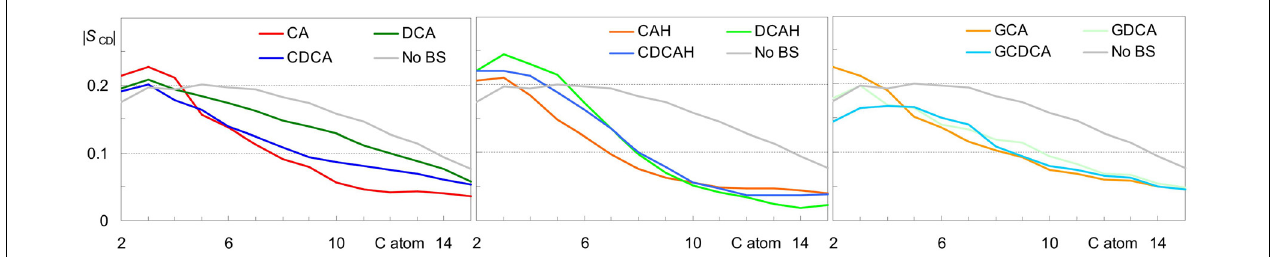
FIGURE 8 | Deuterium order parameter profiles for the palmitoyl chain of POPC for all lipids in the absence of BS (black) and for lipid chains located laterally within 0.6 nm of the COM of a BS molecule. Left, middle and right panels refer to systems with inserted anionic unconjugated, neutral unconjugated and conjugated BS, respectively.